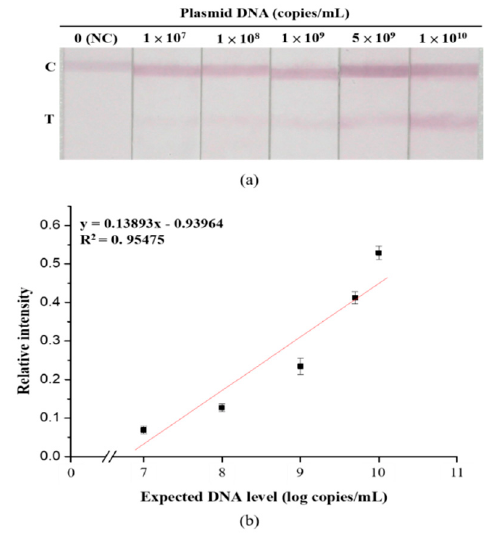
Figure 7. Detectability of the developed lateral flow strip. ( a ) Photographic images of the developed lateral flow strip in the presence of various concentrations of BKV plasmid DNA. ( b ) Resulting calibration curve of ( a ). Data are presented as the mean and SD. NC: Negative control.